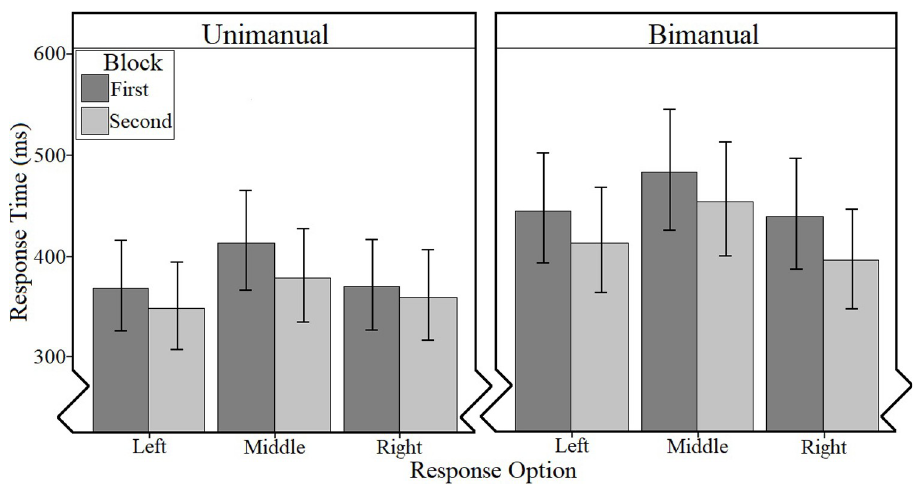
Fig 5. Estimated means [and 95% confidence intervals] for response time (ms) as a function of setup, Motoric Response and Block (Simple Task).